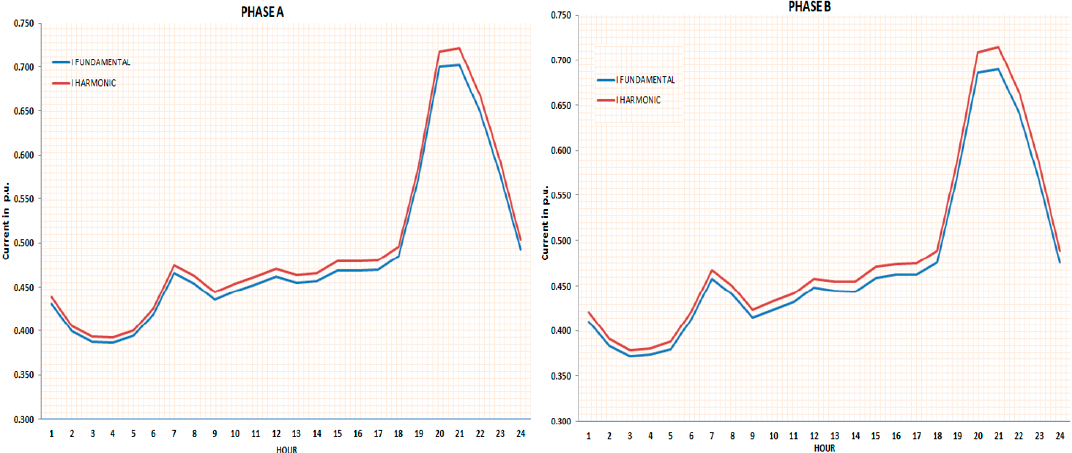
ff ective current. Phase A and B in